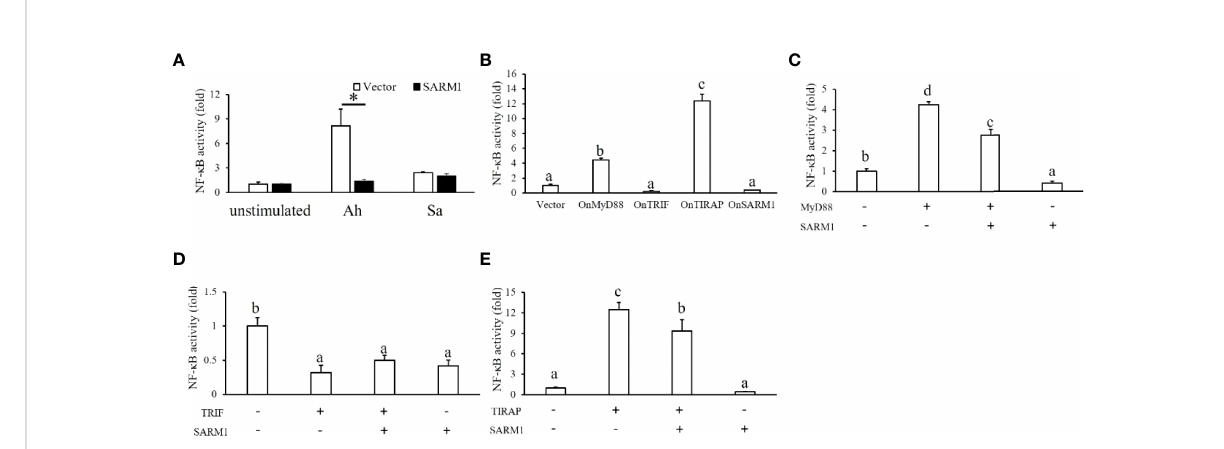
FIGURE 9 Luciferase assay on the activation of a NF- k B-luc reporter by OnMyD88, OnTRIF, OnTIRAP, and OnSARM1 in THK cells. (A) THK cells were transfected with the pNF- k B-Luc reporter with an empty vector or OnSARM1-3×FLAG expression plasmids. Forty-eight hours post transfection, the cells were treated with lysates from Aeromonas hydrophila (Ah, 10 m g bacterial protein/ml culture medium) or Streptococcus agalactiae (Sa, 10 m g bacterial protein/ml culture medium) for 16 h; this was followed by luciferase assay analysis (n = 3). (B) Activity of the NF- k B-luc reporter was determined in the THK cells transfected with the expressing plasmids of OnMyD88 , OnTRIF , OnTIRAP , and OnSARM1 (n = 3). (C – E) THK cells were co-transfected with the NF- k B-luc reporter together with OnMyD88 , OnTRIF , OnTIRAP , and OnSARM1 expressing plasmids alone or in a combination of two, and the corresponding empty vector was used as a control. Forty-eight hours post transfection, the cells were harvested to detect luciferase activity (n = 3). The values are shown as mean + SD. Signi fi cant differences between the OnSARM1 or vector transfected group [ (A) , unpaired sample t-test] or between the experimental groups [ (B – E) , one-way ANOVA and Tukey ’ s post-hoc test] are indicated by asterisks or different letters (P < 0.05),